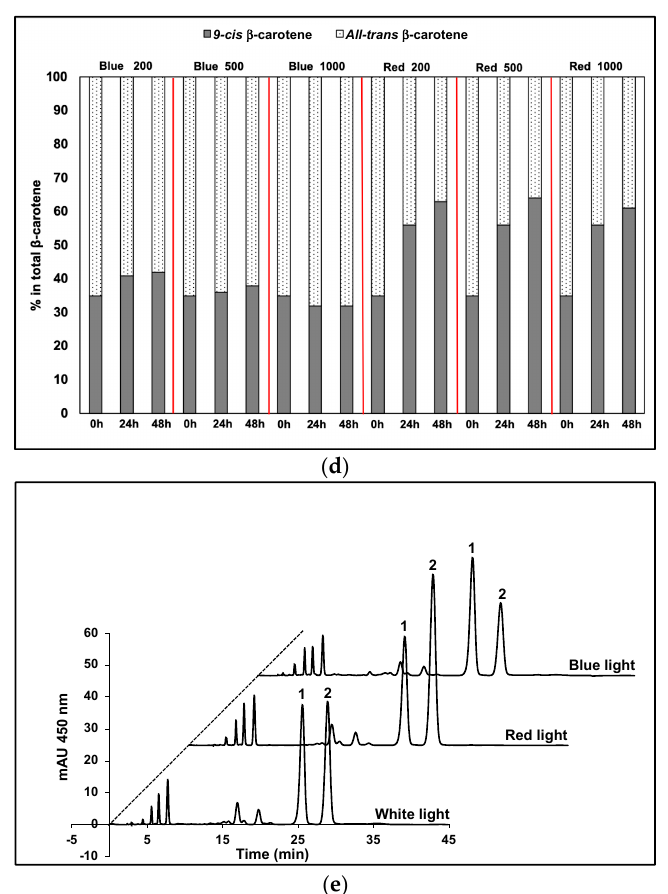
Figure 1. Cultivation of D. salina under continuous blue or red LED light at three different light intensities of 200, 500 and 1000 µmol m − 2 s − 1 for 48 h. ( a ) Cellular content of 9-cis β C, ( b ) cellular content of all-trans β C; ( c ) 9-cis / all-trans β C ratio. ( d ) Percentage of 9-cis and all-trans β C in total β C . ( e ) HPLC profiles at 450 nm of carotenoid extracts from D. salina cultivated under continuous white light, red light or blue light, each at 1000 µmol m − 2 s − 1 for 48 h. Peak 1: all-trans β -carotene; peak 2: